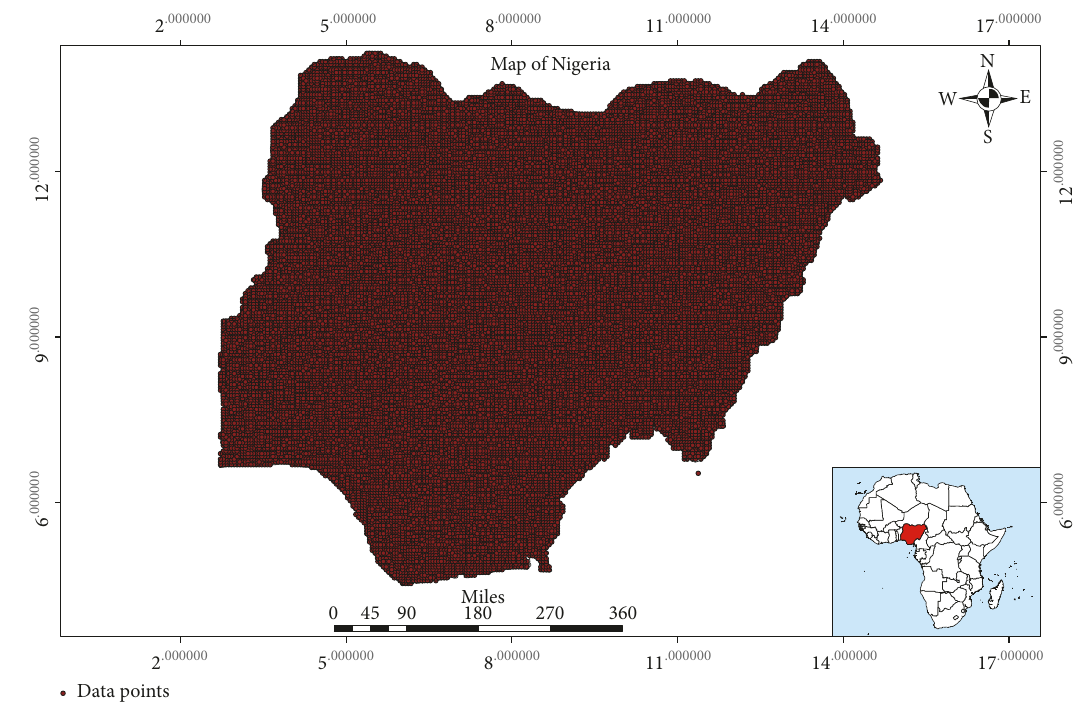
Figure 1: Study area in Nigeria with data